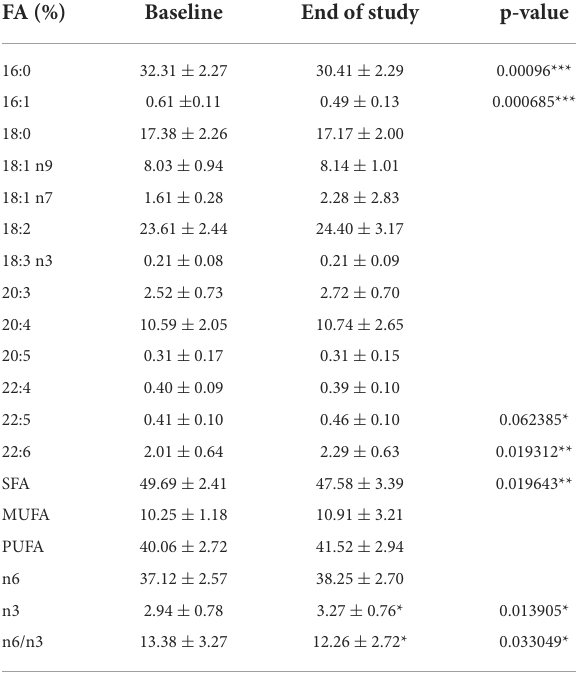
TABLE 2 Fatty acid profile in plasma phospholipids of study participants at baseline and after 4 week